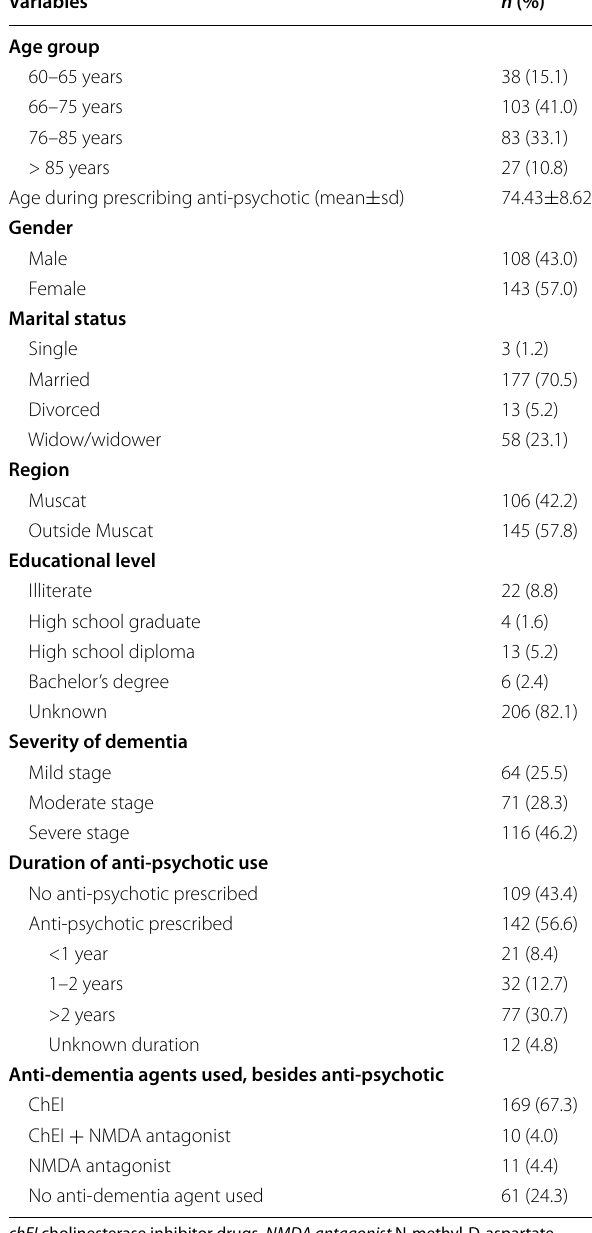
Table 1 Patients’ demographic and clinical variables